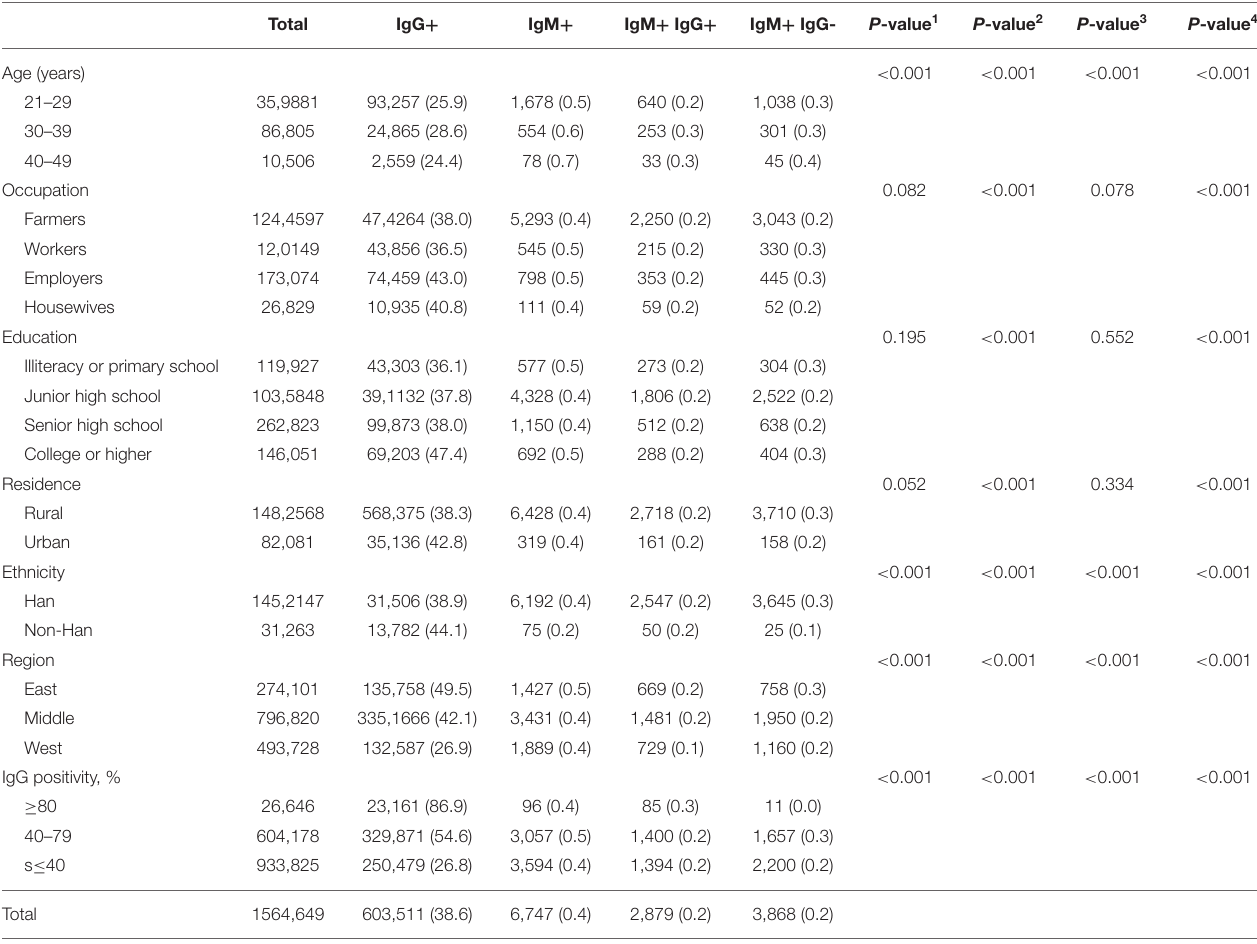
TABLE 1 | Demographic and regional characteristics of cytomegalovirus